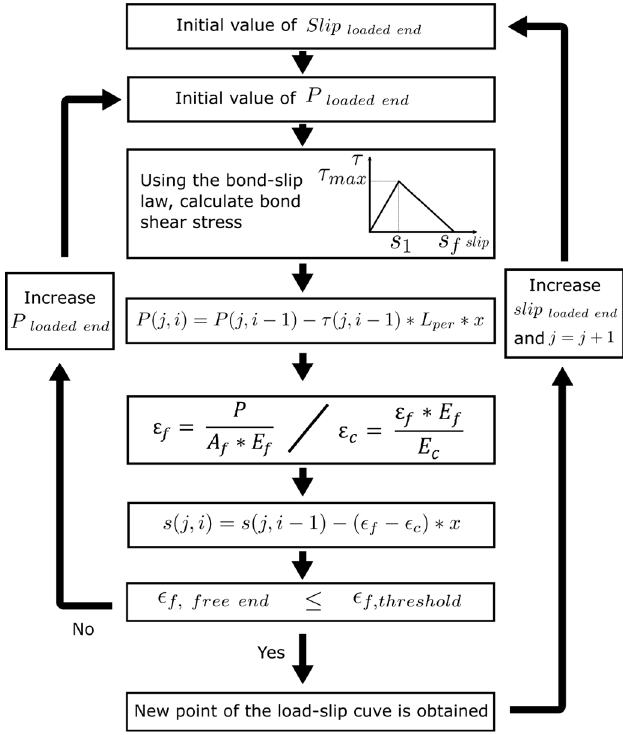
Figure 3. Flowchart of the numerical procedure.